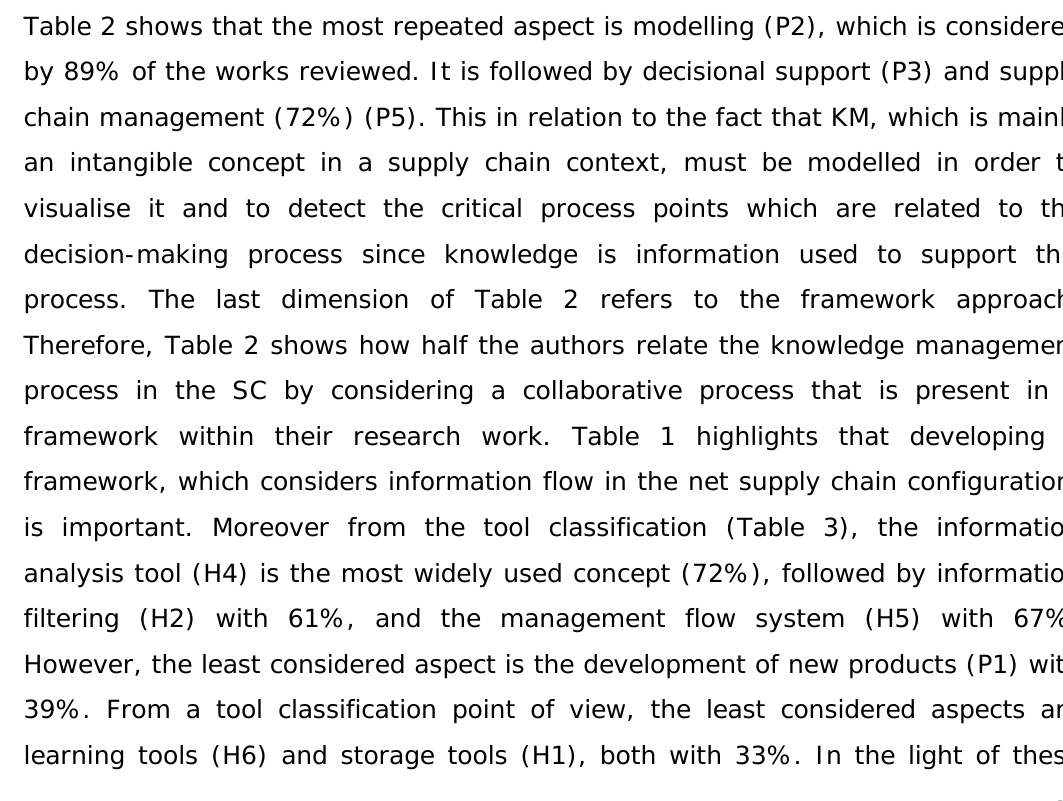
Table 2. “Main aspects identified”. Table 3. “Tool